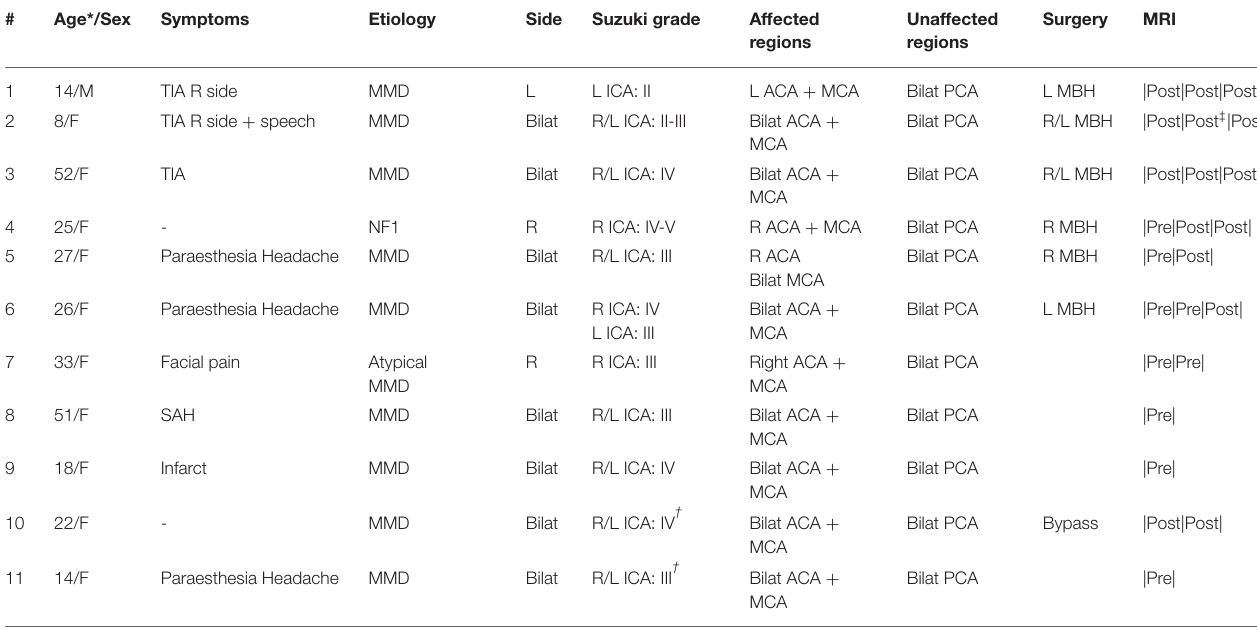
TABLE 1 | Patient